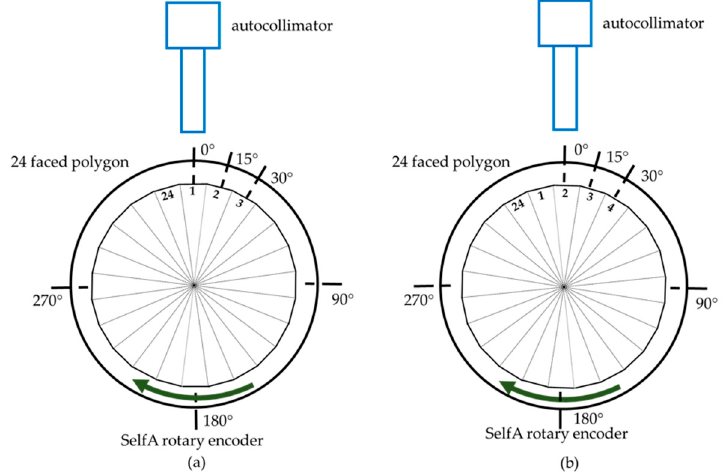
Figure 5. Shift-angle method for the polygon. ( a ) S = 0 ◦ for the first face as the starting face. ( b ) S = 0 ◦ for the second face as the starting face.